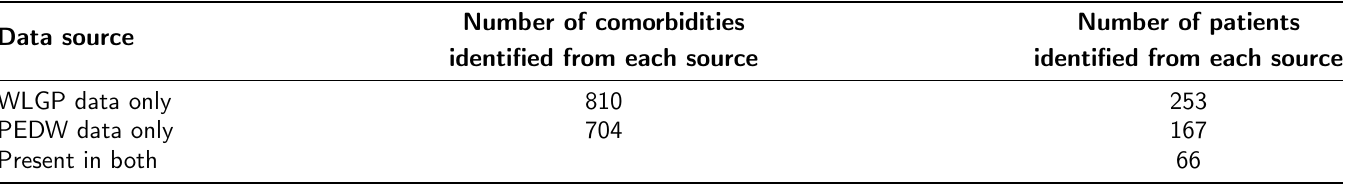
Table 3: The number of comorbidities for the patients in the BIO cohort identified from each data source demonstrates the importance of including both